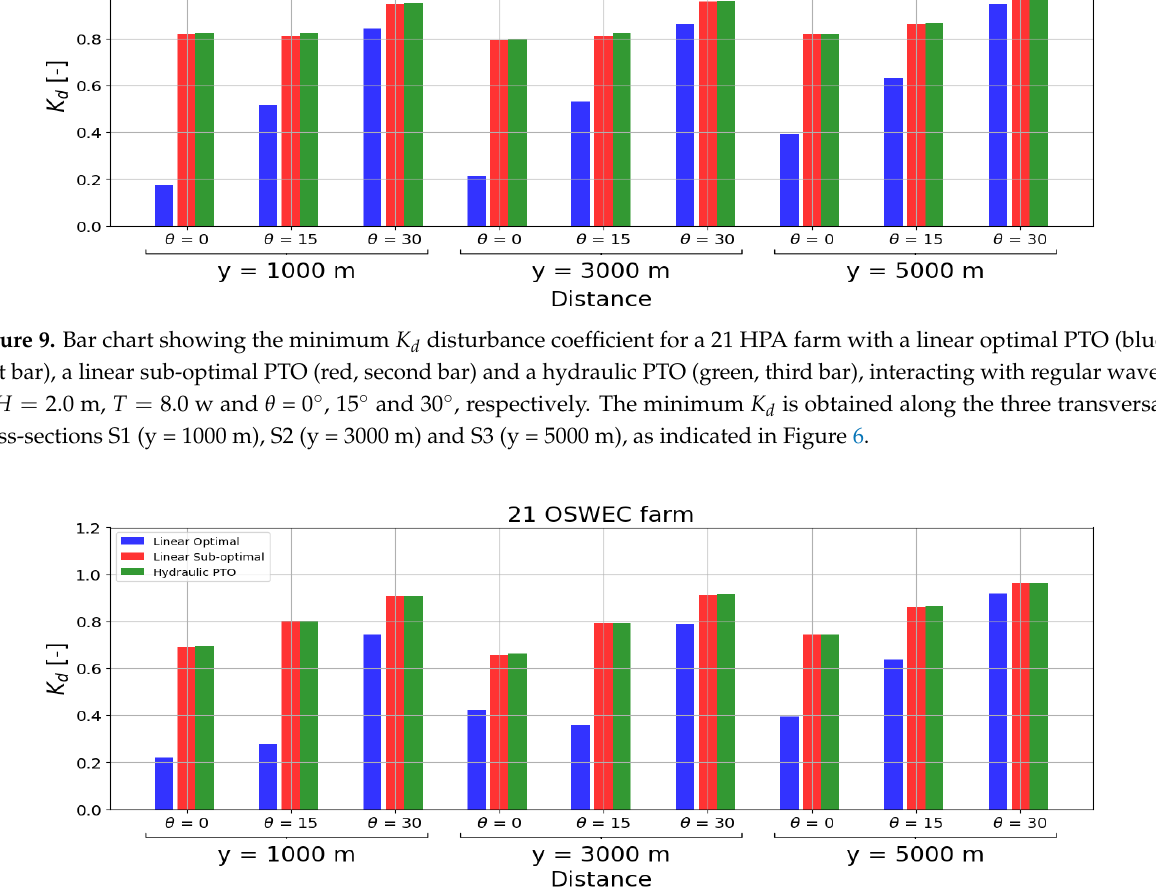
Figure 10. Bar chart showing the minimum K d disturbance coefficient for a 21 OSWEC farm with a linear optimal PTO (blue, first bar), a linear sub-optimal PTO (red, second bar) and a hydraulic PTO (green, third bar), interacting with regular waves of H = 2.0 m, T = 8.0 s and θ = 0 ◦ , 15 ◦ and 30 ◦ , respectively. The minimum K d is obtained along the three transversal cross-sections S1 (y = 1000 m), S2 (y = 3000 m) and S3 (y = 5000 m), as indicated in Figure